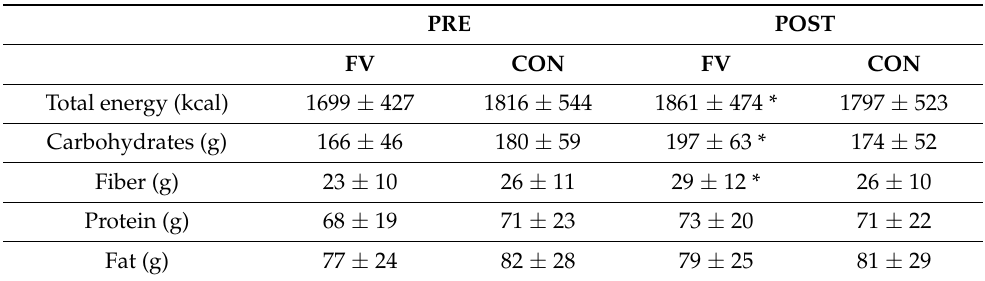
Table 3. Total energy and macronutrient intakes before (PRE) and after (POST) the 16-week period. PRE POST FV